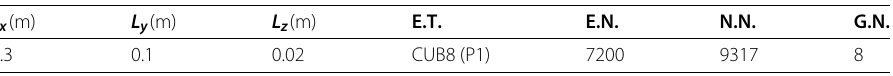
Table 2 Geometry parameter of FE